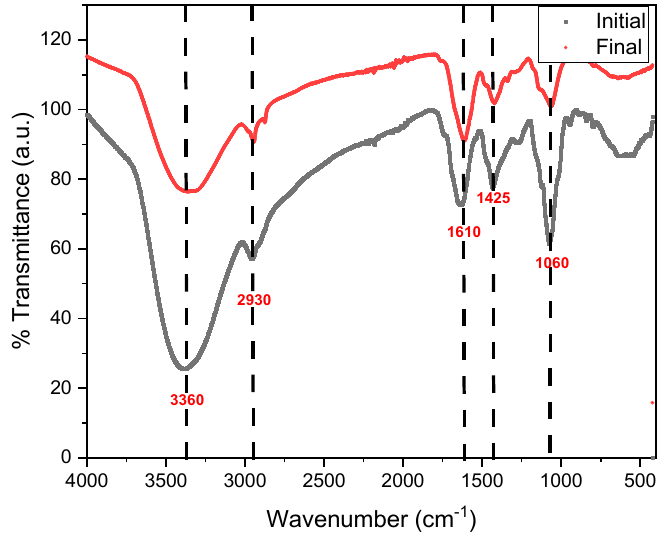
Figure 4. FTIR spectrophotometry of the initial and final pineapple waste.